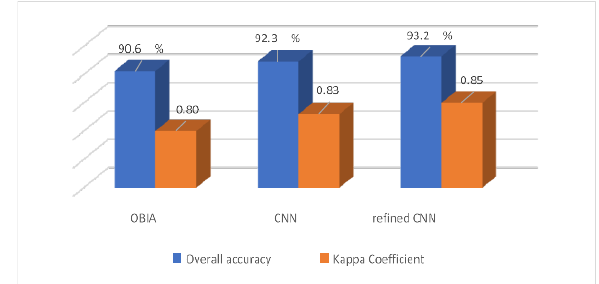
Figure 9. Overall accuracy and kappa coefficient of classification by OBIA, CNN and refined